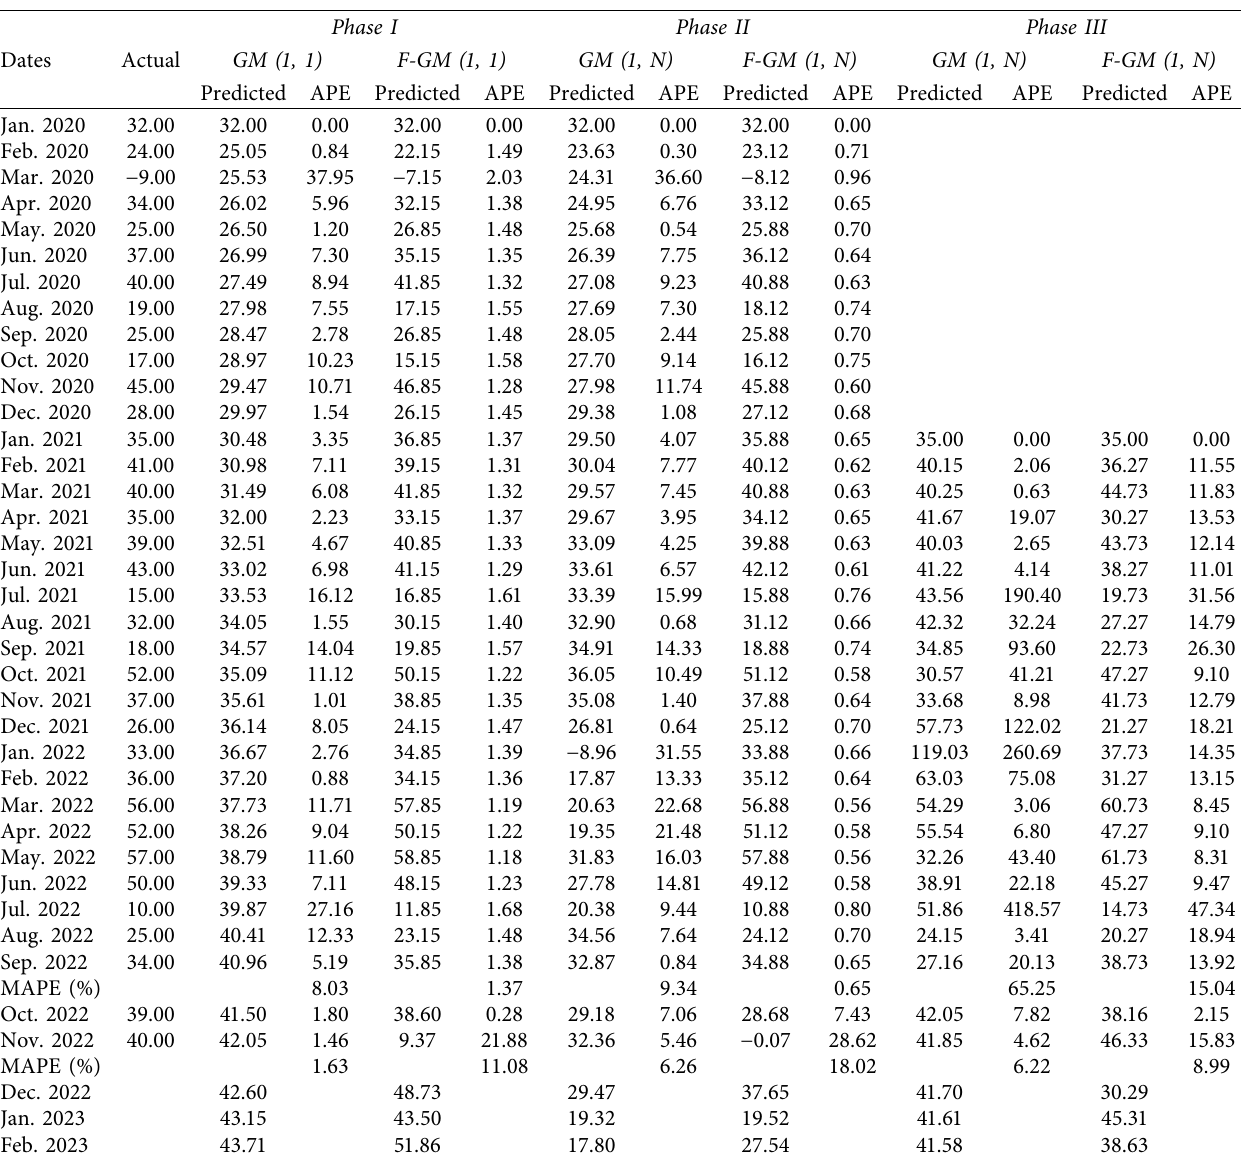
Table 6: Prediction results of travel sentiment in